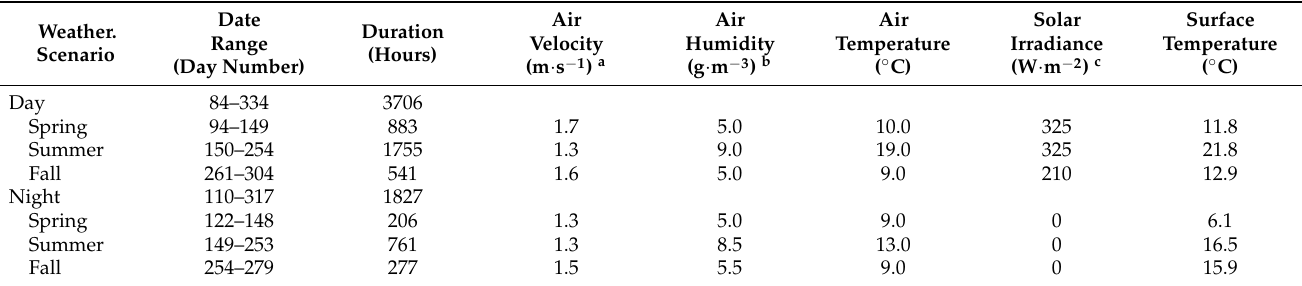
Table 1. Selected atmospheric parameters in the study area.